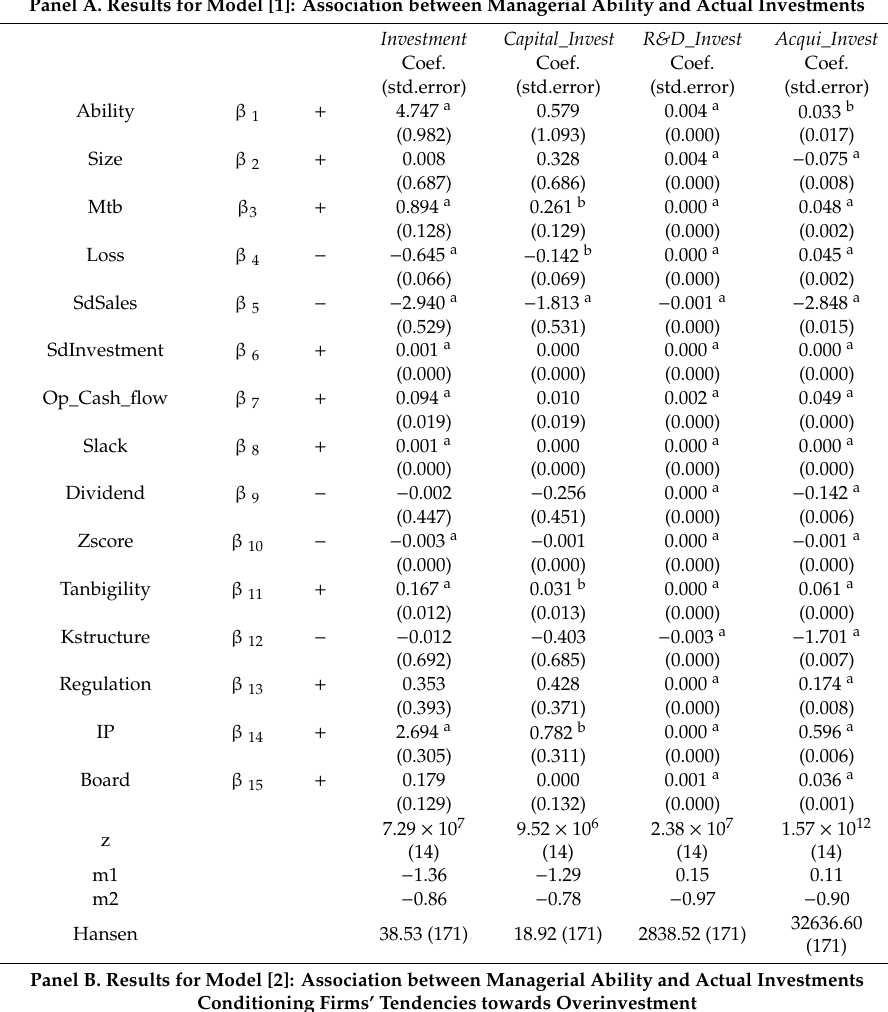
Table 5. Regression results for managerial ability and investments. Panel A. Results for Model [1]: Association between Managerial Ability and Actual